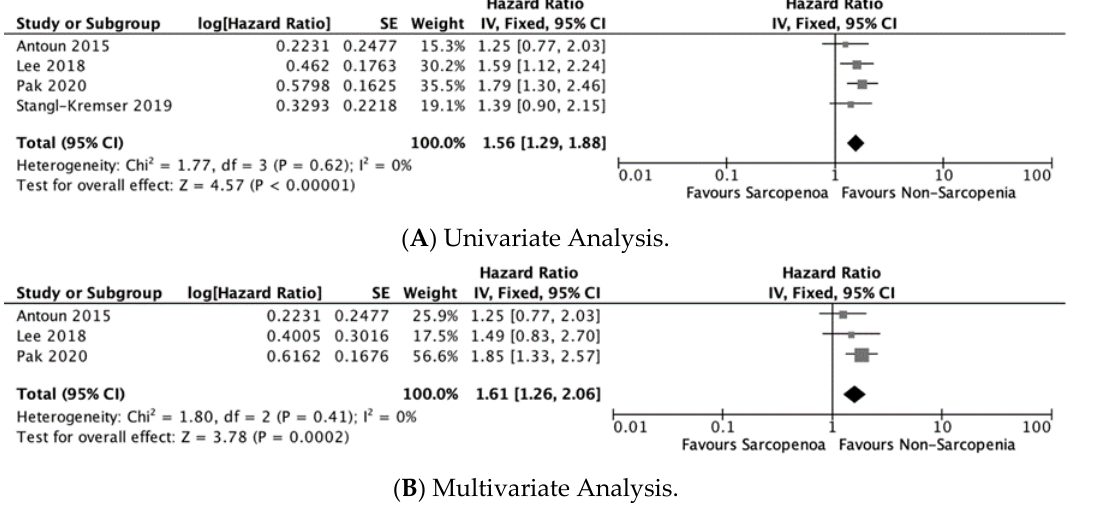
Figure 4. Forest plots for progression-free survival